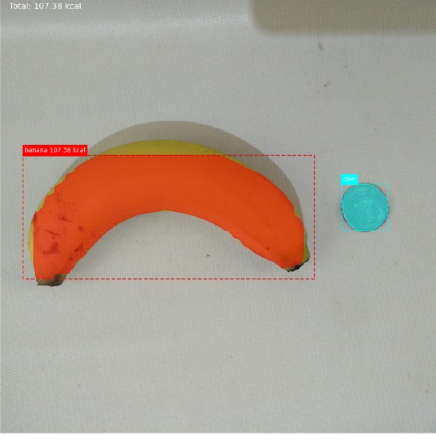
Fig. 7 Prediction result of a banana